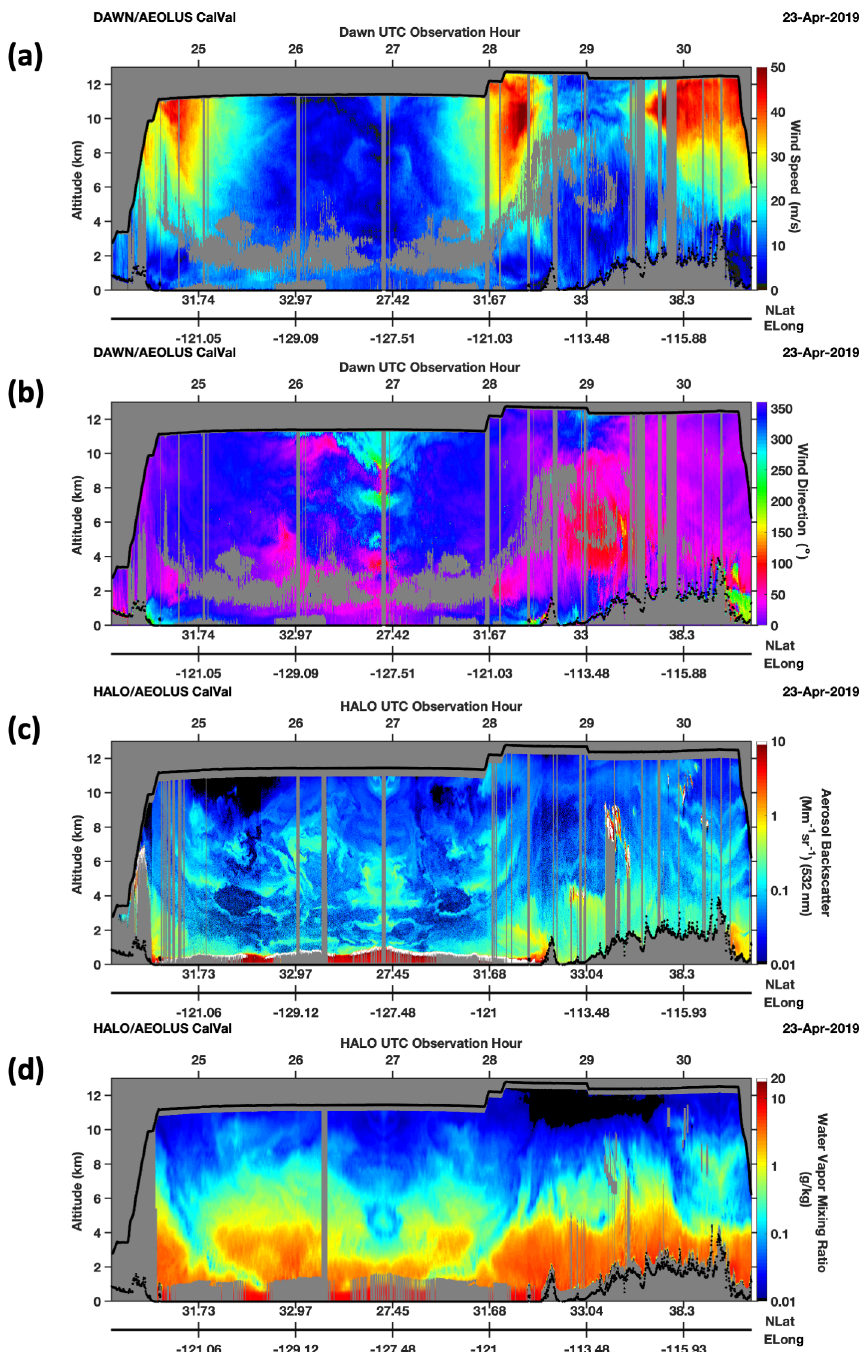
Figure 6. (a, b) DAWN wind speed and direction for the 22 and 23 April 2019 flight. (c) HALO 532nm aerosol backscatter. (d) HALO water vapor mixing